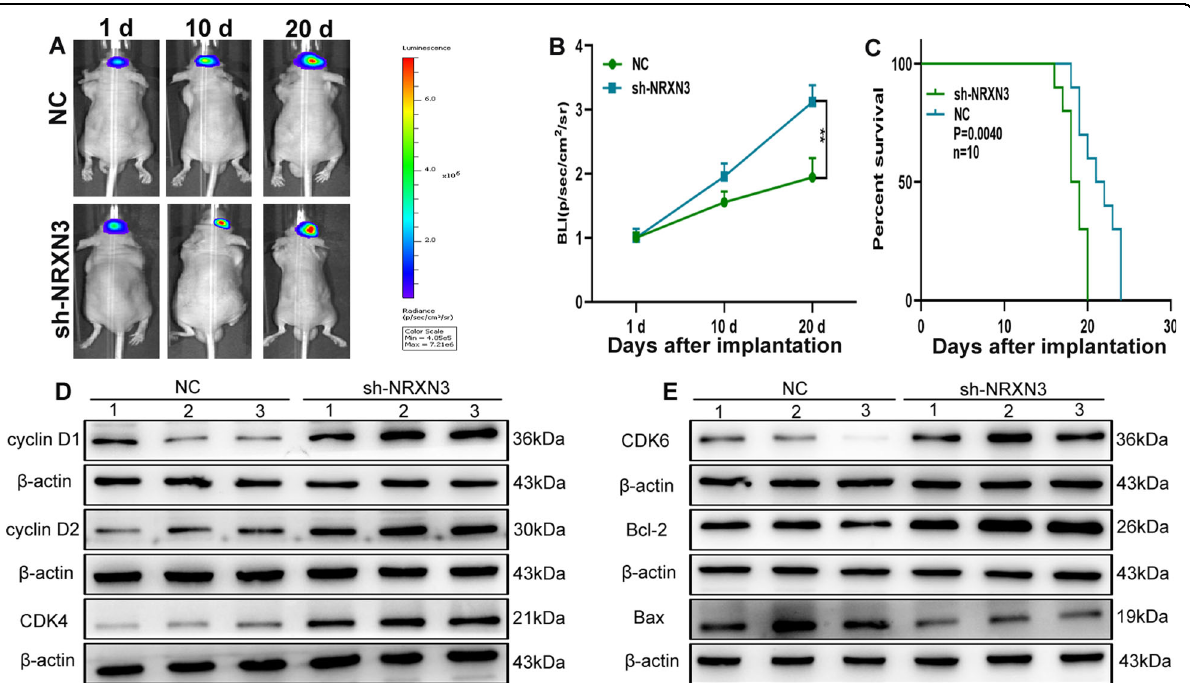
Fig. 7 NRXN3 inhibits glioma growth in vivo. A , B Bioluminescent images of the intracerebral tumours of nude mice (10 mice in per group) were acquired on days 1, 10 and 20 after glioma cell implantation. C Overall survival was compared between the sh-NRXN3 and shNC groups with Kaplan – Meier survival analysis. D , E The expression of proliferation- and apoptosis-related proteins was detected by western blot analysis. Data are expressed as mean ± SD, ** P <